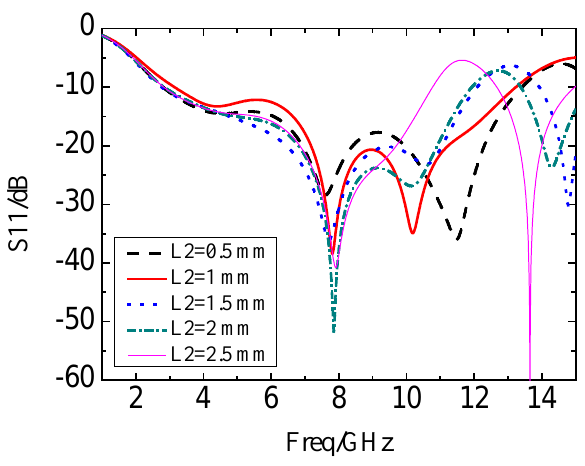
Figure 9. Simulation results of the reflection coefficient with different L 2 .